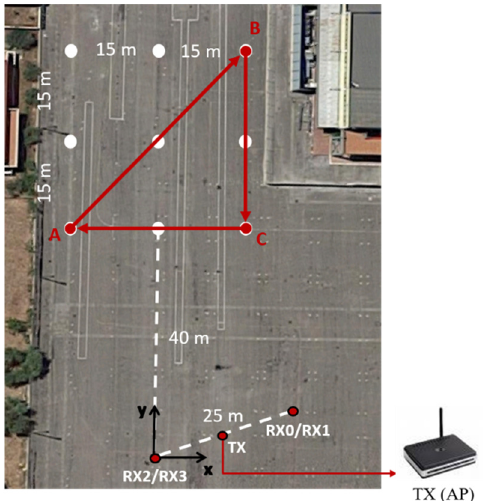
Figure 10. Experimental setup and nominal path for the human target case.